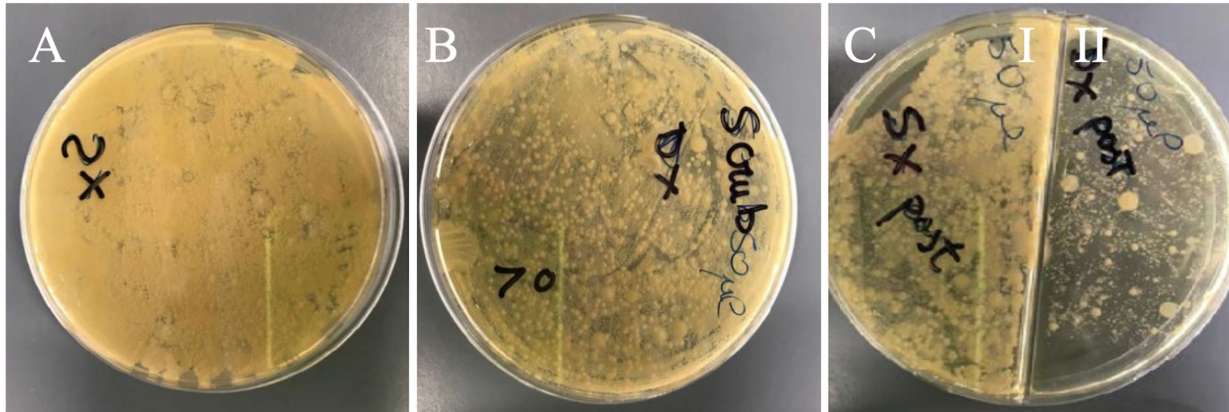
Figure 2. Microbiological analysis of the fragments from the front and rear hoof sole of one horse. The plates show the microbial growth on Nutrient Agar, after incubation at 37 ◦ C for 24 h. ( A ) Sample from the left front hoof sole after superficial cleaning; ( B ) Sample from the right front hoof sole after two consecutive 3 min scrubs with Povidone-iodine (PI); ( C ) I, Sample from the left rear hoof sole after superficial cleaning; II, Sample from the right rear hoof sole after application of 10 mL Iron Animals (IA) for 15